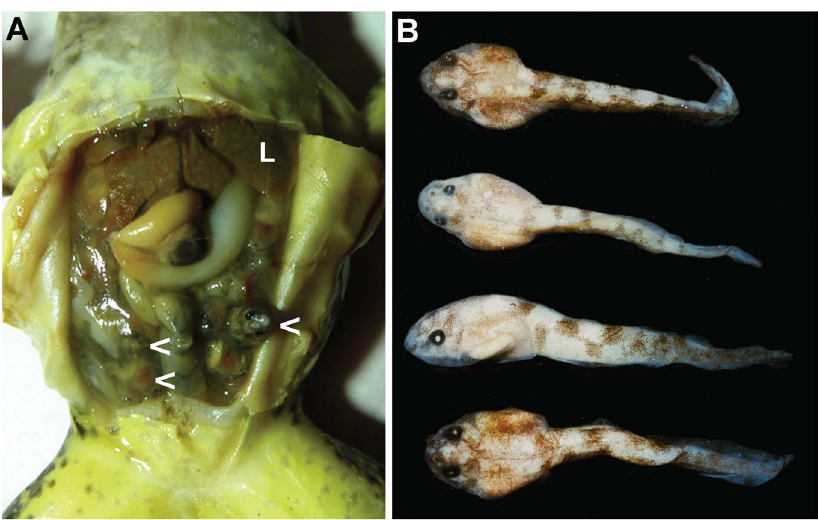
Fig. 2. Gravid Limnonectes larvaepartus with oviductal tadpoles. (A) Intact viscera of gravid female (MZB Amp 22973; L 5 liver and arrows 5 several tadpoles), and (B) four of the preserved tadpoles removed from the oviducts of the same